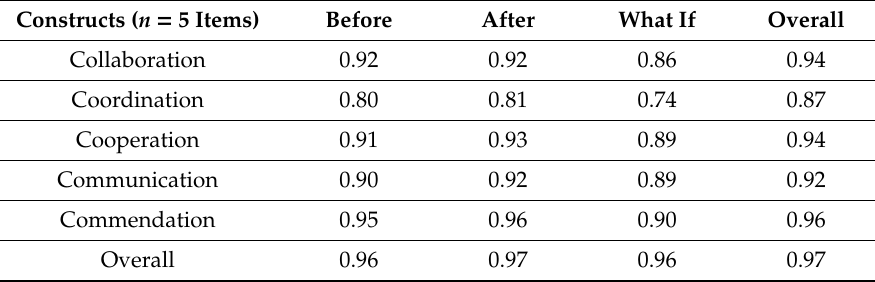
Table 5. IRL-IPL reliability ( n =